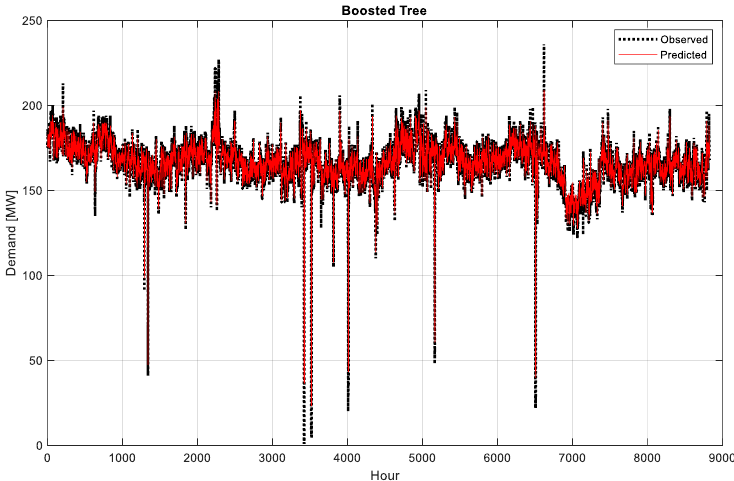
Figure 10. The ESC demand Forecasting using the Boosted Tree model optimized using BO.